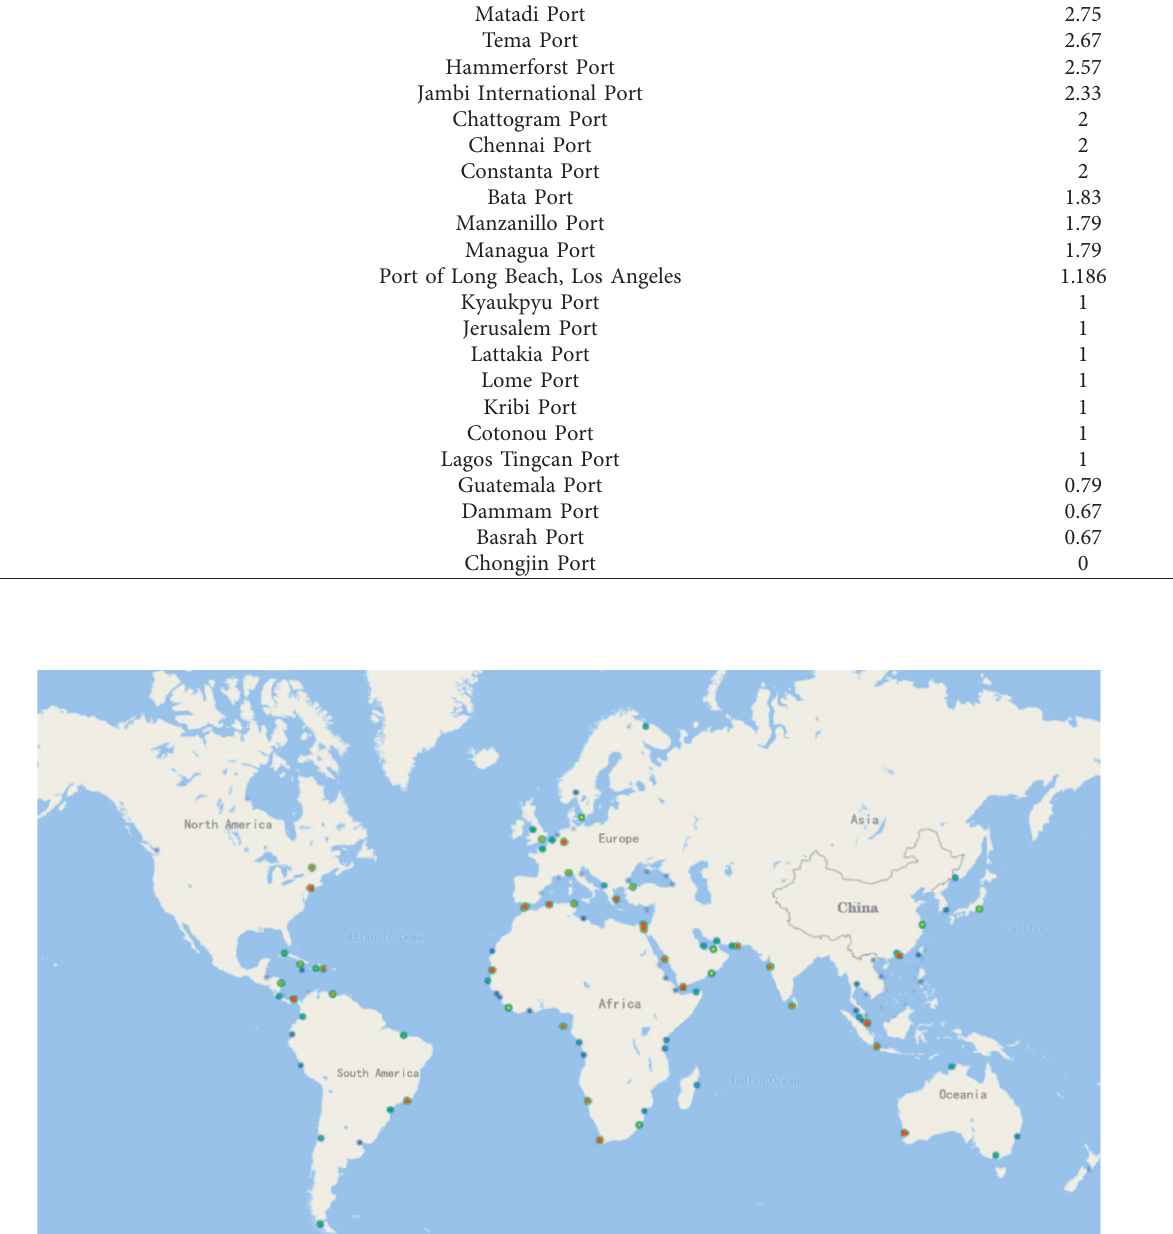
Figure 3: The thermodynamic diagram about the betweenness centrality of each